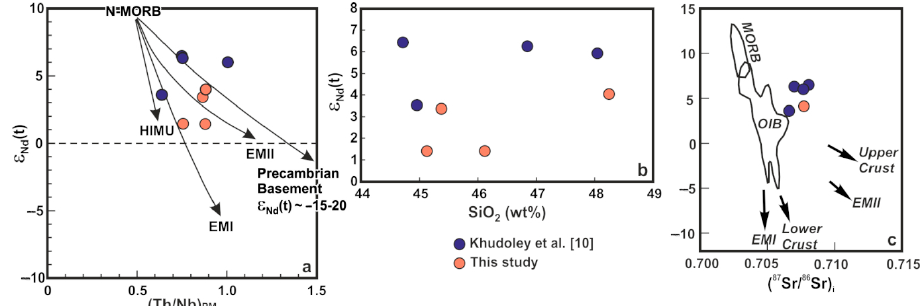
Figure 11. Nd isotope characteristics of the Suordakh event mafic intrusions cutting the Gornostakh Anticline [10] and those cutting the Cambrian units as well (this study) ( a ) ε Nd (t) vs. (Th/Nb) PM . ( b ) ε Nd (t) vs. SiO 2 . No correlation between ε Nd (t) and SiO 2 is shown. Primitive mantle composition ( PM ) is from [49], ( c ) ( 87 Sr/ 86 Sr)i versus ε Nd (t) diagram for the Suordakh event mafic intrusions (from [52,53]). EMI and EMII—enriched mantle sources; HIMU—high µ ( 238 U/ 204 Pb) mantle source.